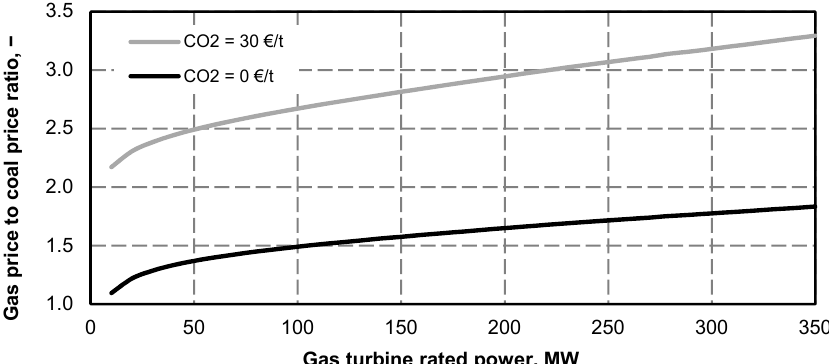
Figure 47. The ratio of unit gas price to unit coal price providing the viability of adding the superstructure of gas turbine and single-pressure recovery boiler as a function of gas turbine rated power for operating the gas turbine with a variable power ( e c = 9.52 PLN/GJ).